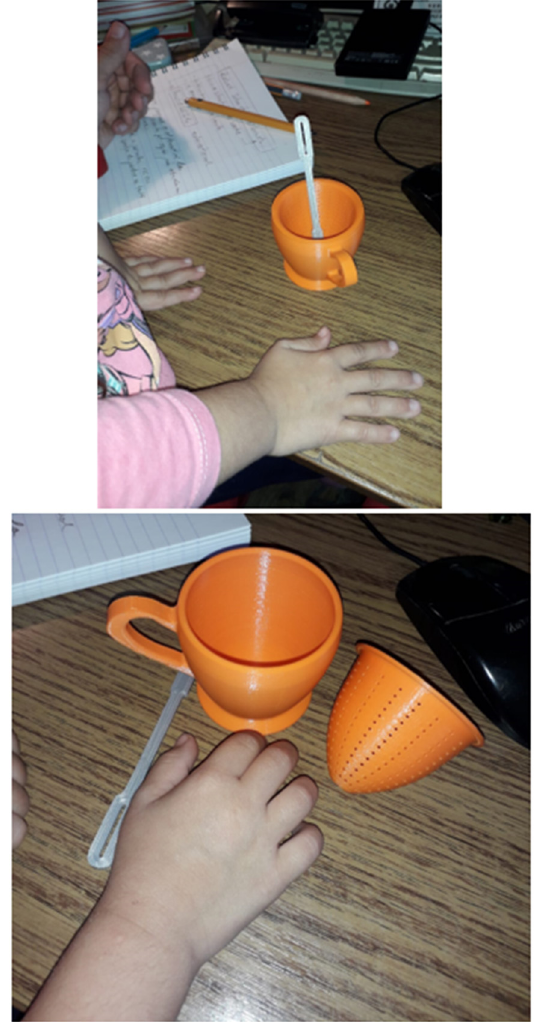
Figure 14. Children’s toy set—teacup.